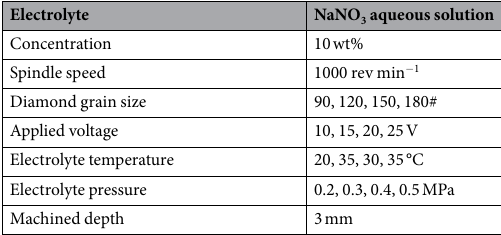
Table 1. Machining conditions 25, 26 .